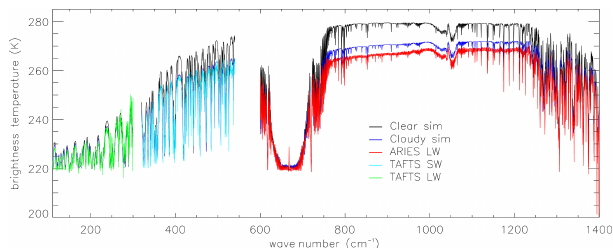
Figure 5. Simulation for case A assuming a cirrus cloud with τ 355 = 0 . 584, composed of ice particles with r eff = 30µm, and Baum et al. (2014) ASC particle habit. The TAFTS LW and SW channel spectra are each a single spectrum. The ARIES LW chan- nel spectrum plotted is a mean of eight ARIES observations, and the width of the curve indicates the standard deviation about the